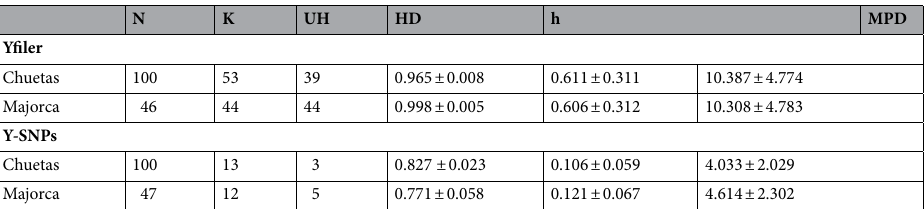
Table 1. Y chromosome molecular diversity indices for haplotypes and haplogroups in Chuetas and Majorcans. N number of individuals, K number of haplotypes/haplogroups, UH unique haplotypes/ haplogroups, HD haplotype diversity ± SD, h gene diversity over loci, MPD mean pairwise differences.